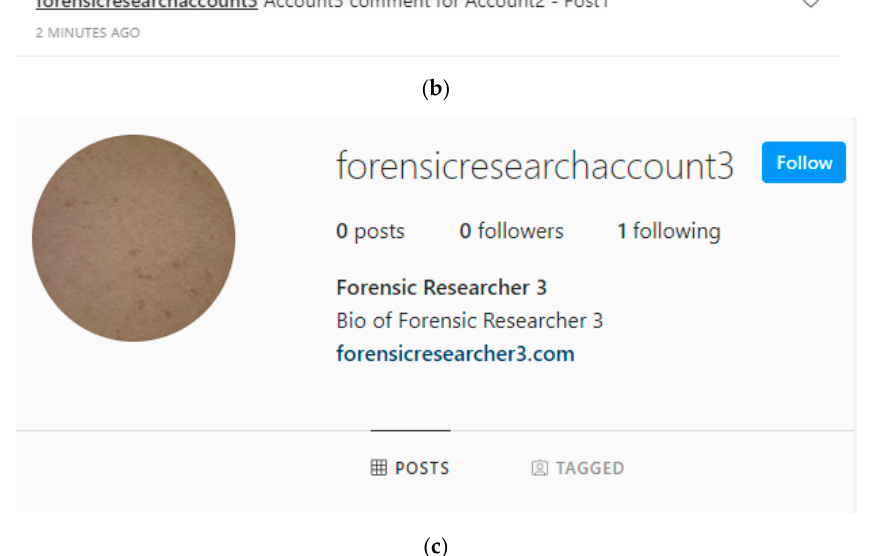
Figure 2. ( a ) Comment is Displayed without Profile Interactions, ( b ) Comment is Displayed with Profile Displayed Through Mouse Hovering, ( c ) Commenting Profile is Visited.